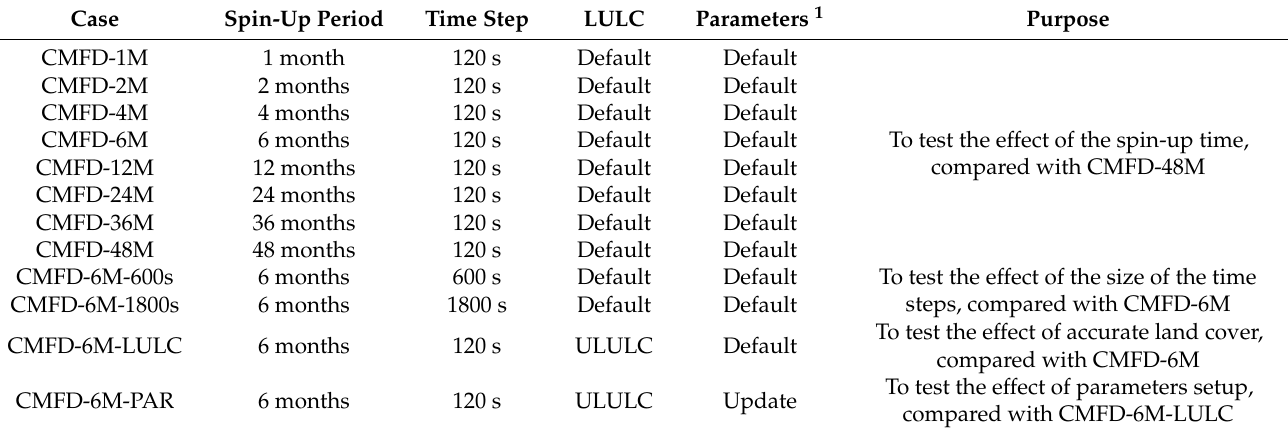
Table 1. The experimental setup for accuracy improvement of the model simulated.